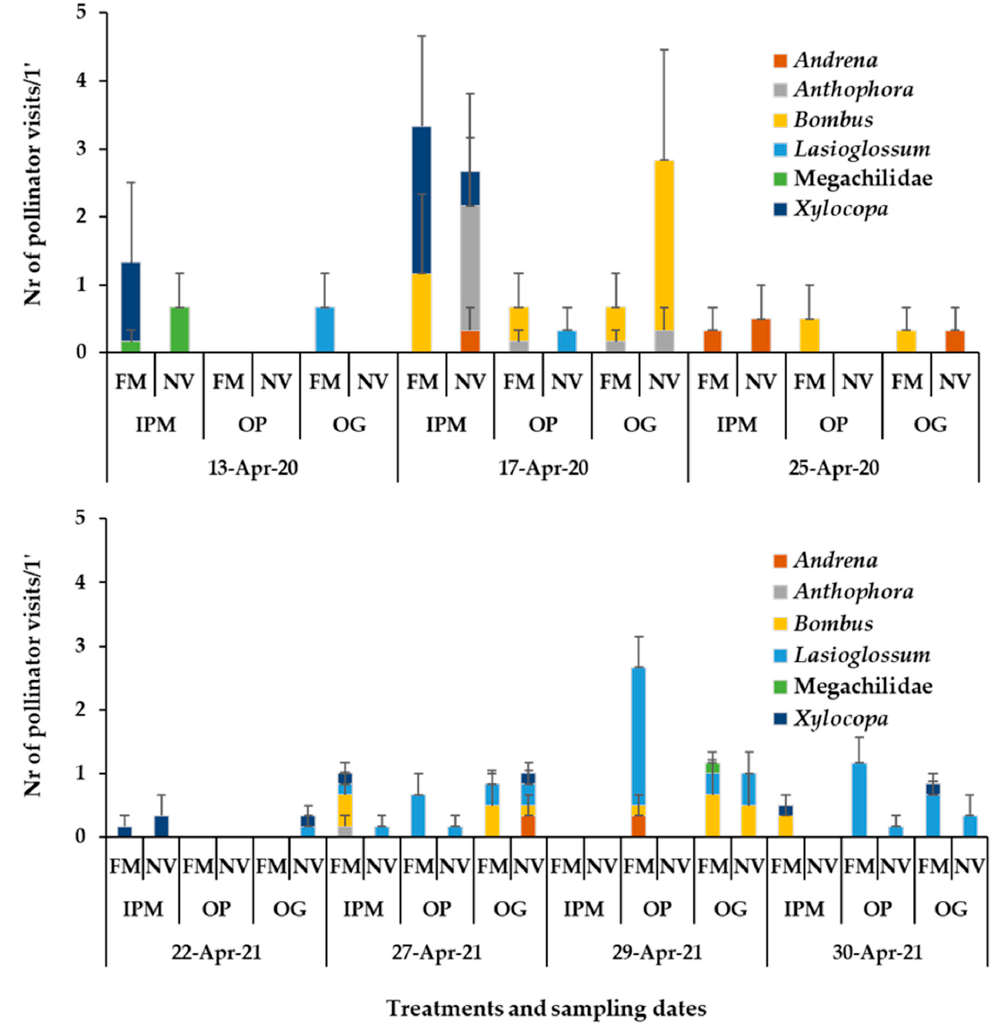
Figure 6. Mean numbers of wild bees recorded on apple flowers (1 min/6.4 m 2 ) in 2020 and 2021. Wild bee taxa are indicated by different colour in each column. FM: sown flowering mixture; NV: natural vegetation (wild plants); IPM: IPM orchard, OP: organic palmette orchard, OG: organic goblet orchard. Vertical bars represent standard error of means.